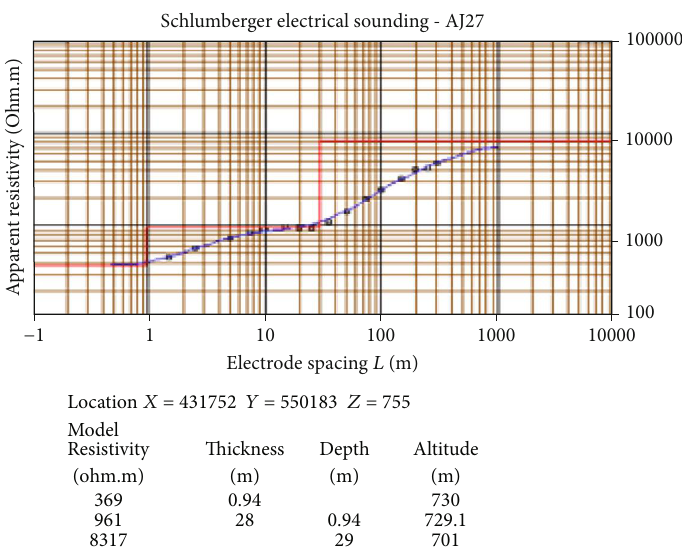
Figure 7: Sounding curves (AJ